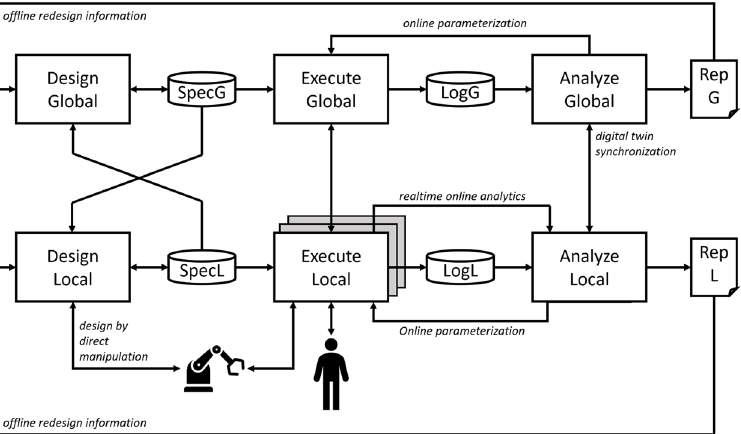
Figure 1. High-level logical software architecture of SHOP4CF [52]. Architecture consists of global and local level, which each consist of design, execute, and analyze modules. The communication between the subsystems can be direct or indirect through different communication means which can store the information on databases (e.g., SpecL).